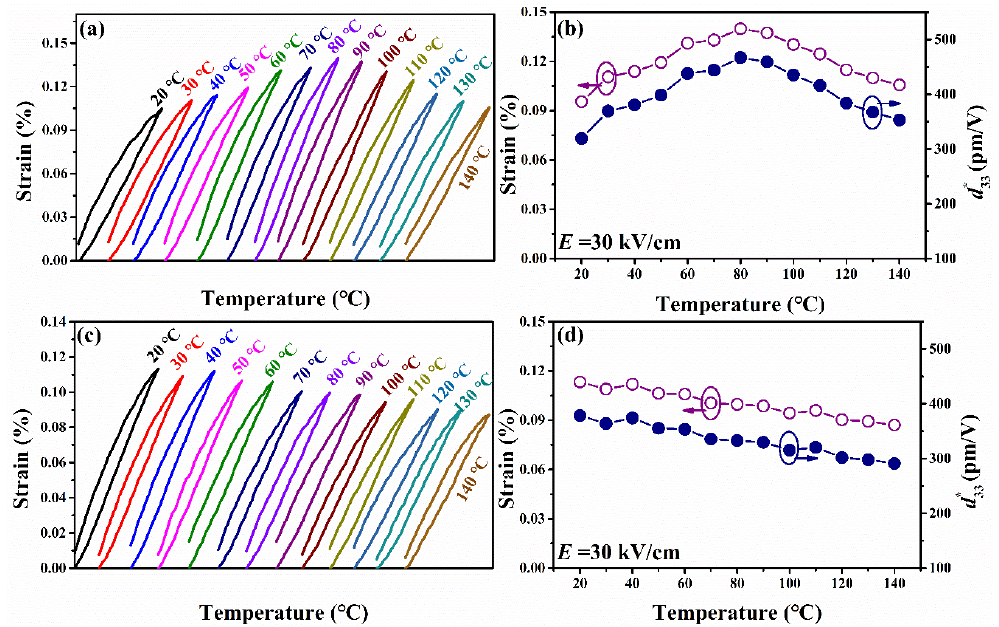
Figure 6. The unipolar S-E curves, strain values and d 33* values for ( a ), ( c ) KNN-UN, ( b ); ( d ) KNN- 800 ceramics measured under different temperatures.